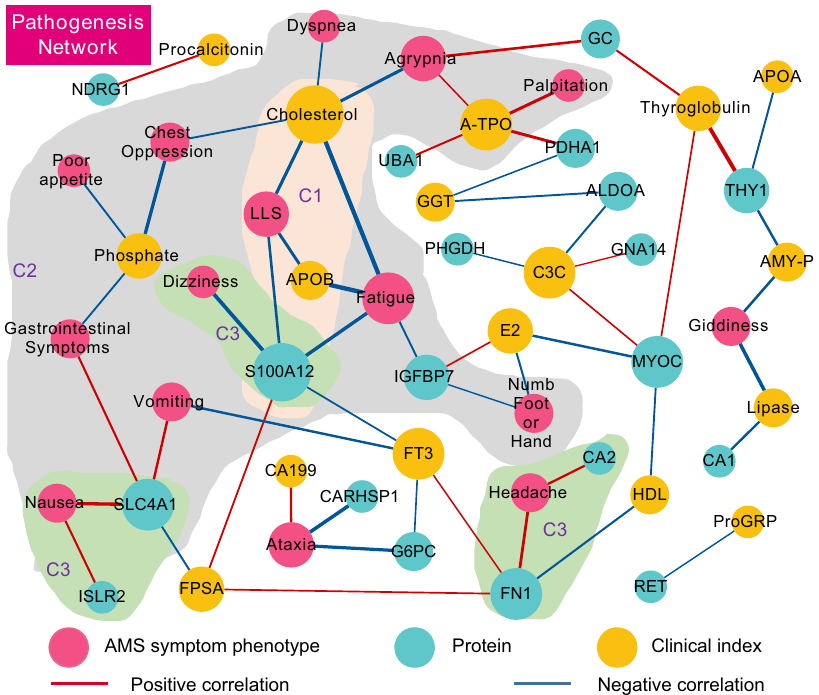
Fig. 5 Network visualization of MRM-identi fi ed DEPs, clinical indexes and AMS symptom phenotypes in the pathogenesis comparison. The network of AMS symptom phenotypes (pink dots), DEPs (blue dots), and clinical indexes (yellow dots) was connected based on Spearman correlation coef fi cients and statistical signi fi cance in 30 individuals with AMS. The edges showing a positive correlation (red line) and a negative correlation (blue line) with p values < 0.05 are shown. The thickness of the edges corresponds to the absolute value of the correlation coef fi cients. The size of the node is proportional to the number of edges from the node. Cluster C1 (light orange background area), cluster C2 (light green), and cluster C3 (light gray) are labeled C1, C2, and C3 (purple fonts), respectively. S100A12 was found to be associated with the LLS of AMS and with several proteins, such as CA2 and SLC4A1, which suggests their potential for development as novel clinical